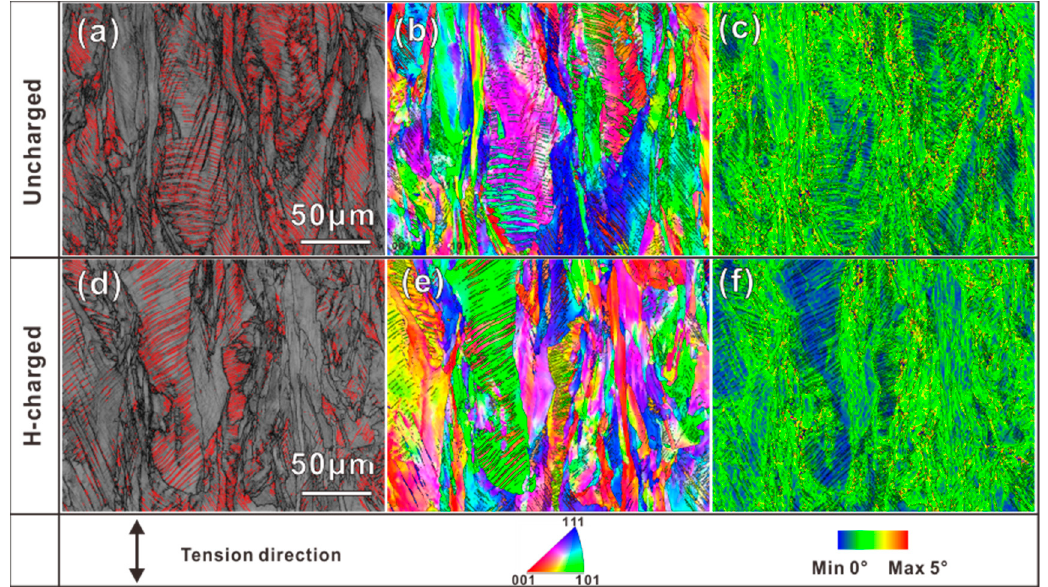
Figure 7. EBSD maps of the lateral fracture surfaces of ( a – c ) uncharged sample and ( d – f ) H-charging sample. ( a , d ) image quality (IQ) maps, ( b , e ) IPF orientation maps, ( c , f ) kernel average misorientation (KAM) maps.